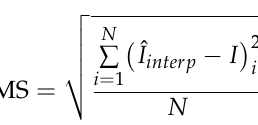
Figure 5. The mean values of VTEC for different approaches in 2014.11